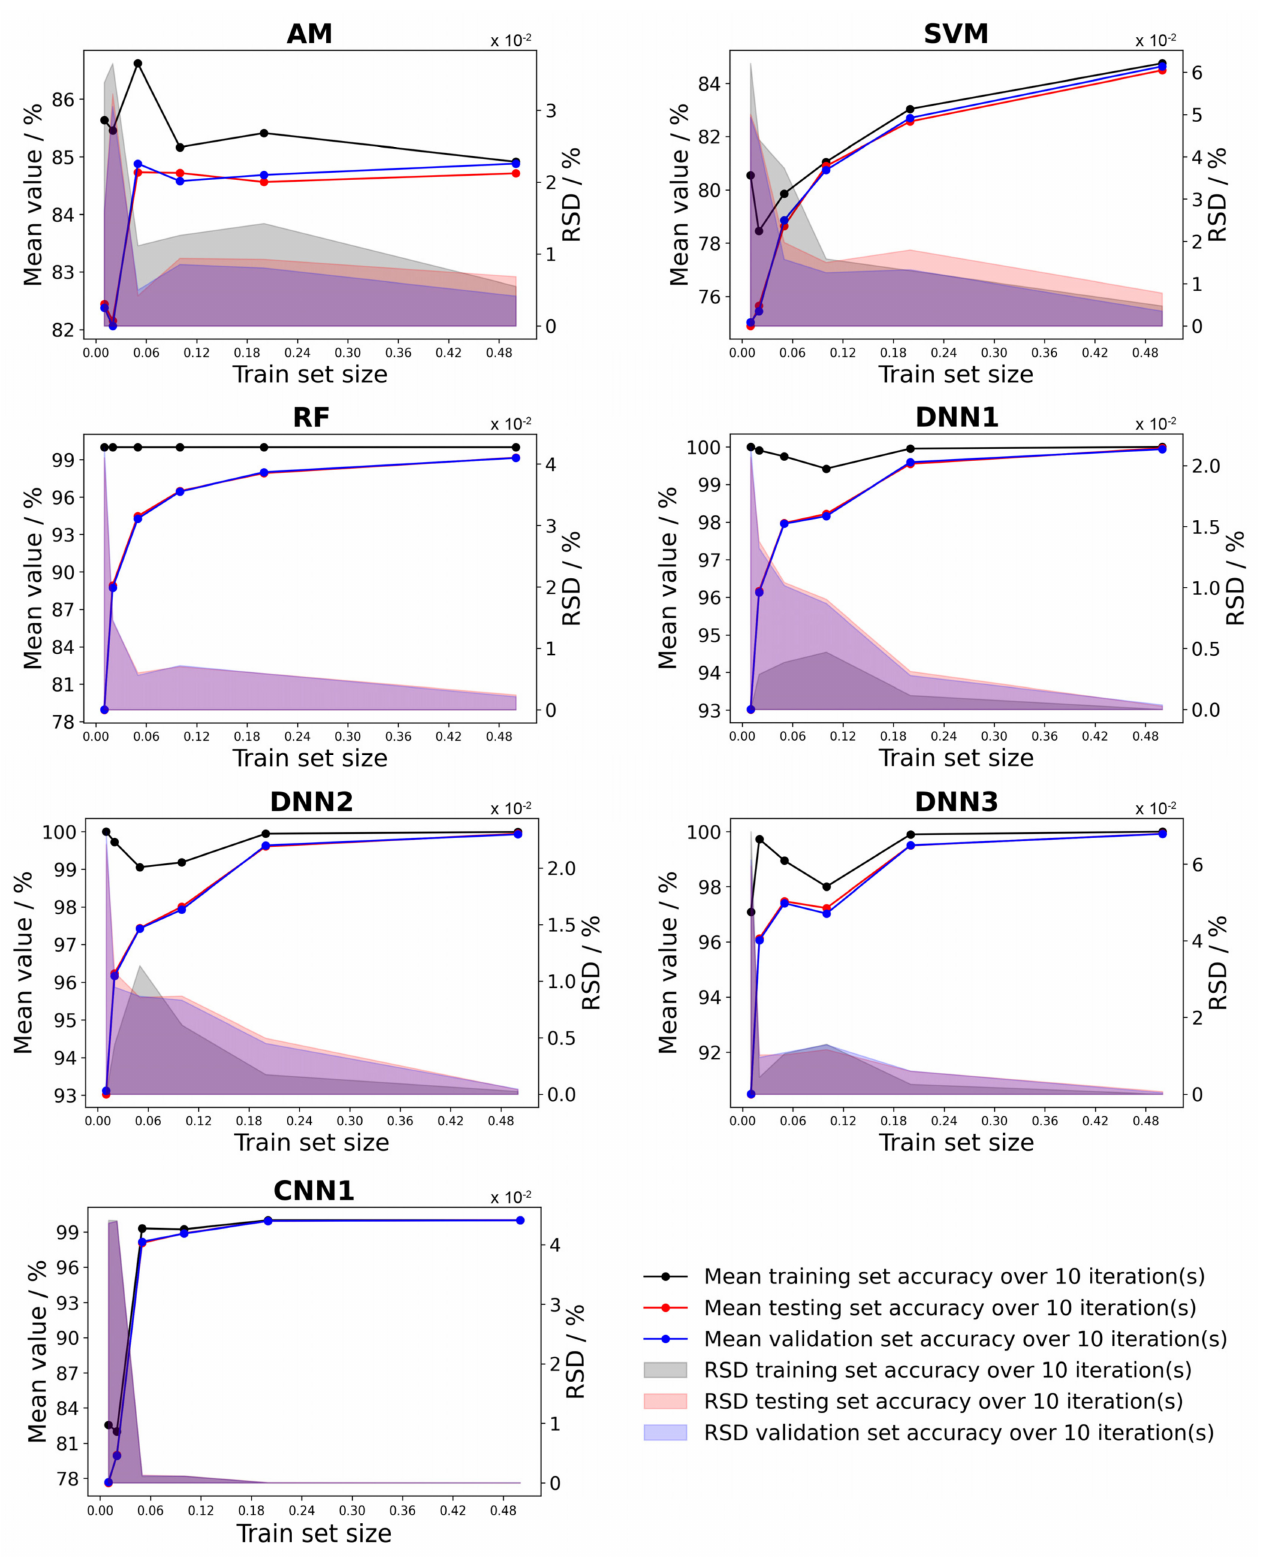
Figure 7. Accuracy and RSD as functions of the training set size for different machine learning classification algorithms over 10 iterations, using full